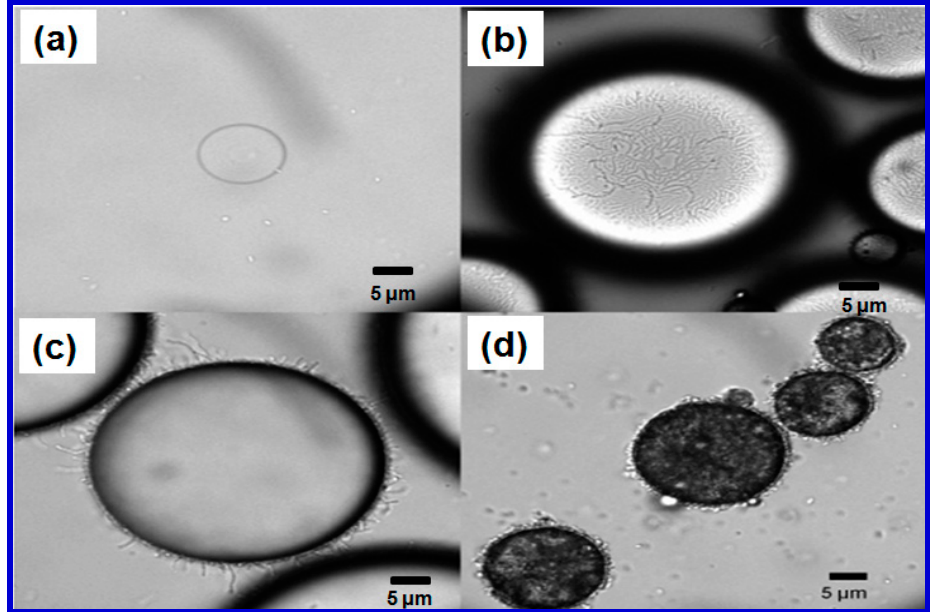
Figure 4. ( a ) Poor accessibility and emulsifying capability of E. coli (the circle) towards oil droplets. Good affinity and emulsifying capability of acinetobacter baylyi ADPWH-alk (the circles) towards the surface of ( b , c ) the mineral oil droplets; and ( d ) the curde oil droplets. Reprinted with permission from